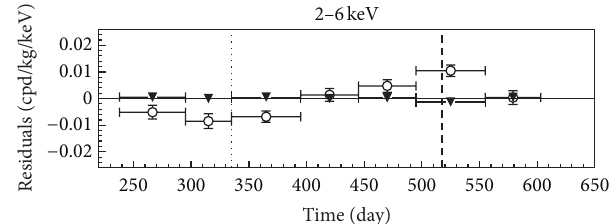
Figure 4: Experimental residual rates of DAMA/LIBRA-phase1 single-hit events (open circles), class of events to which DM events belong, and, for multiple-hit events (filled triangles), class of events to which DM events do not belong. They have been obtained by considering for each class of events the data as collected in a single annual cycle and by using in both cases the same identical hardware and the same identical software procedures. The initial time of the figure is taken on August 7th. The experimental points present the errorsasverticalbarsandtheassociatedtimebinwidthashorizontal bars. Analogous results were obtained for the DAMA/NaI data